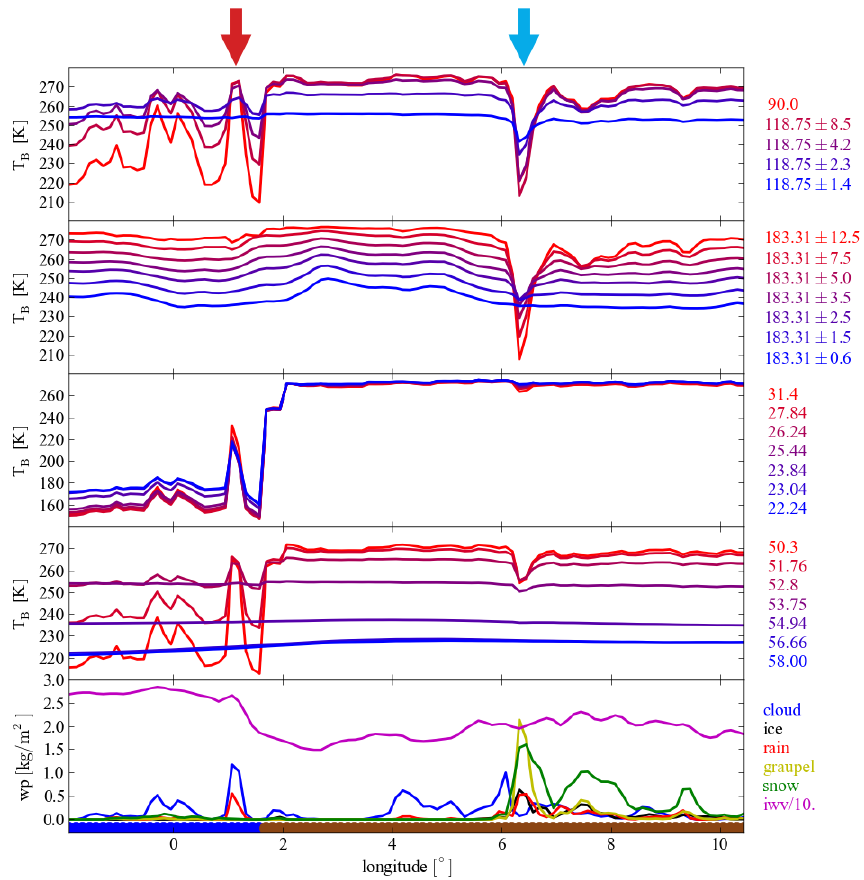
Figure 5. Integrated hydrometeor contents (bottom row) and simulated brightness temperatures along a cross section from west to east through a long-lasting precipitation event on 19 September 2001 at 18:00UTC over Hoek van Holland (see Fig. 4). For a detailed description see text.